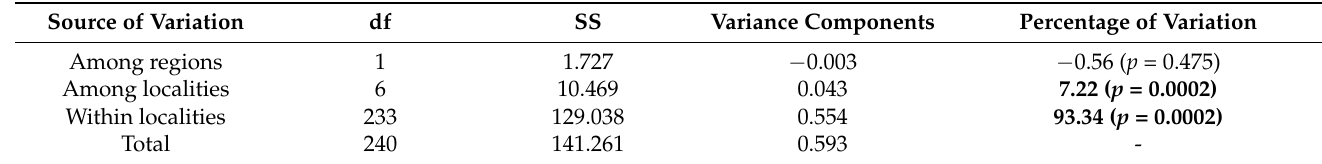
Table 2. Outcomes of AMOVA analysis based on the variability of the tRNA leu -cox2 intergenic region analyzed for 8 localities grouped in two regions South (L, V, S and T) and North (S, Vr, DS and FG) parts of Serbia. Source of Variation df SS